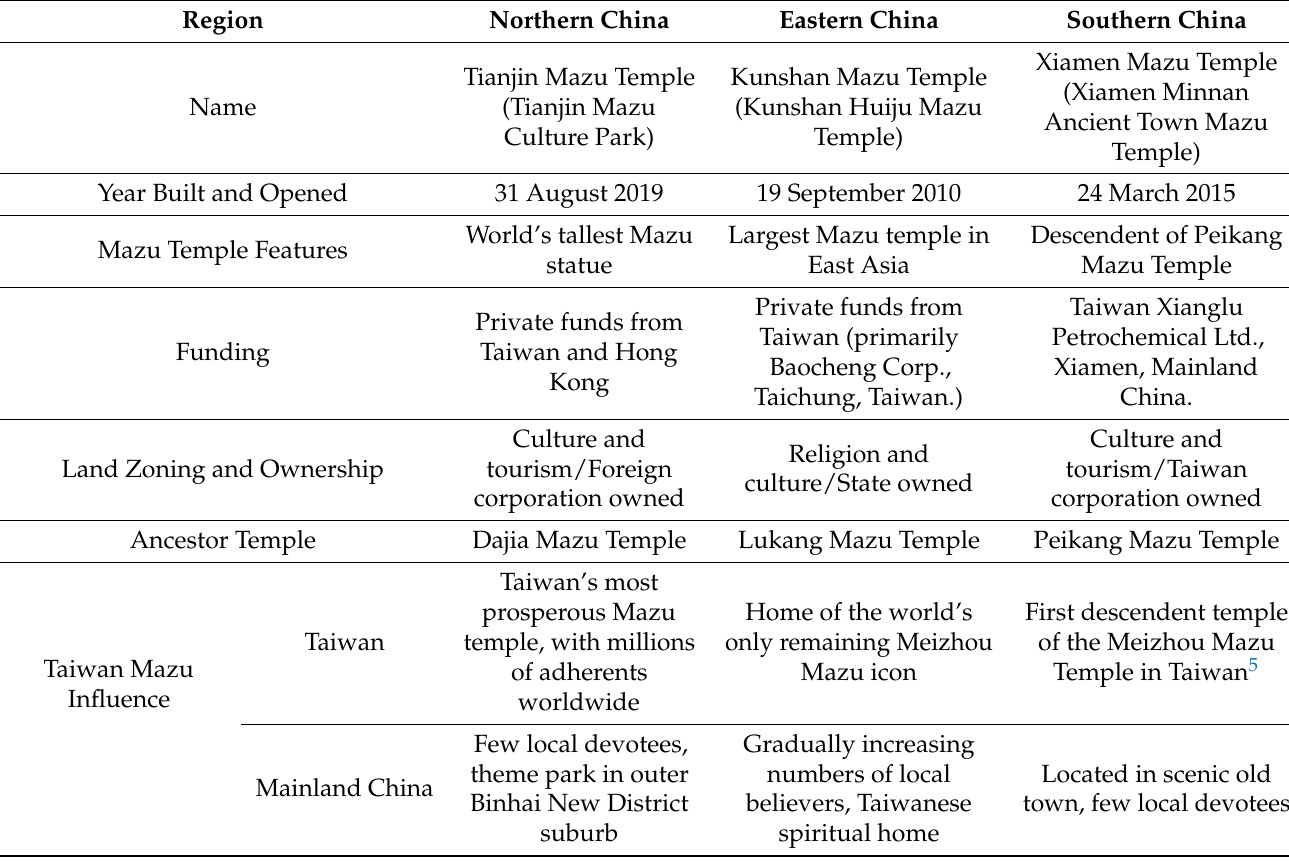
Table 2. Features of the construction process of the Kunshan, Xiamen, Tianjin Mazu temples.